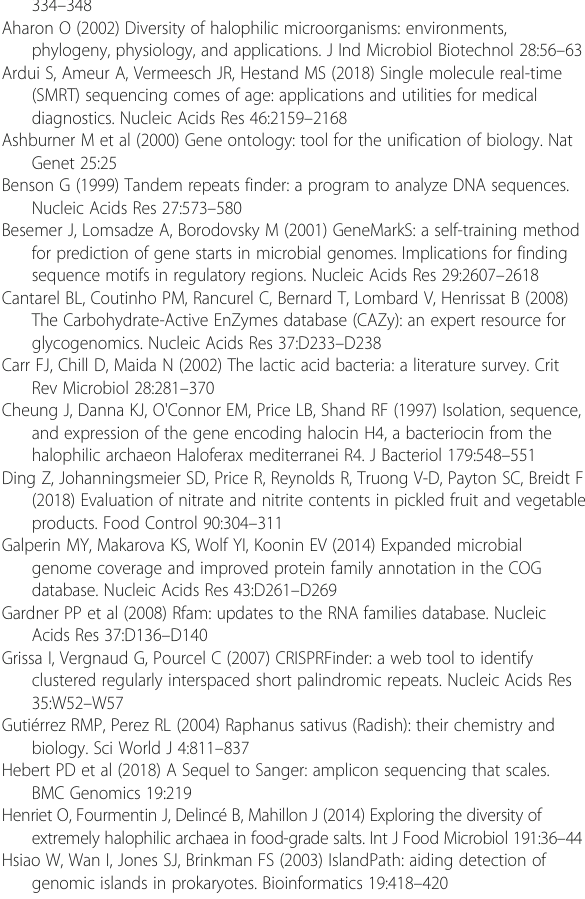
Additional file 1: Figure S1. GO classification of genome function in Halomicrobium sp. ZPS1. Figure S2. KEGG categories of coding proteins in Halomicrobium sp. ZPS1. Figure S3. Phylogenetic tree based on 16S rRNA sequences of Halomicrobium sp. ZPS1. Bootstrap values greater than 50% are shown. Scale bar represents substitutions per